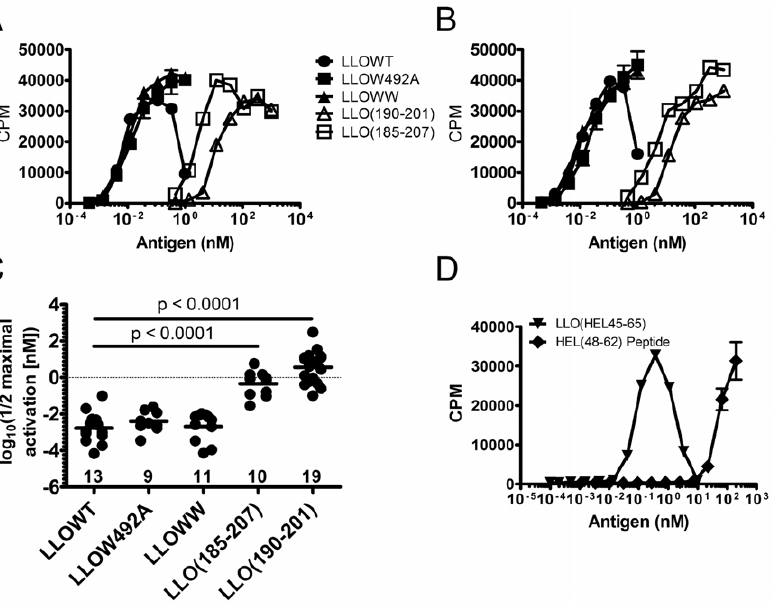
Figure 4. Antigenicity of LLO to CD4 T cells is independent of cytotoxicity. A–B. C57BL/6 BMDC (5 6 10 4 ) and the LLO-specific hybridomas (5 6 10 4 ) ( A ) 57-3 or ( B ) LL73 were incubated with the indicated concentrations of LLO variants or the peptides for , 16 hrs and T cell activation was determined. C. The half-maximal dose of antigen required to activate T cell hybridomas in 62 independent assays was calculated using non-linear regression fitting of the dose-response plots. The plot shows the log 10 of the computed half-maximal activation value. Each dot represents and individual T cell assay. The geometric mean is given for each column. p values were calculated by student T test following validation of normal distribution through D’Agostino & Pearson omnibus normality test. There was a statistical significance in the reduced dose requirement for presentation of LLOWT, LLOW492A, and LLOWW when compared to LLO(190–201) or LLO(185–207) peptides (p , 0.0001). D. B10.BR PEC (10 5 ) and the 3A9 T cell hybridoma specific for HEL(48–62) (5 6 10 4 ) were incubated with either HEL(48–62) peptide or LLO(HEL48–65) fusion protein for , 16 hr. and tested for T cell activation by CTLL-2 assay. For ( A ), ( B ), and ( D ) dots represent the mean 6 S.D. for triplicate values at each antigen dose.